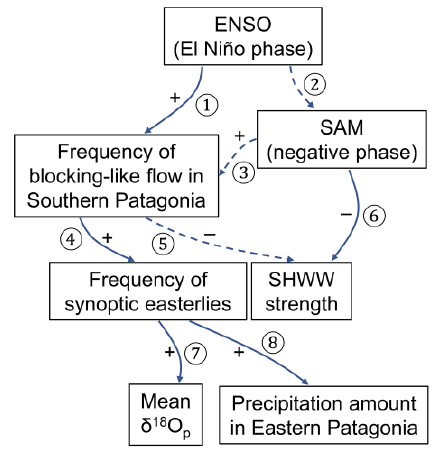
Figure 9. The process-based interpretive diagram to link the large-scale climate mode with regional climate and δ 18 O p in Southern Patagonia in a paleoclimate setting. The plus and minus symbols show the direction of changes (strengthening or weakening, respectively). The solid and dashed arrows show the direct and indirect connections, respectively. The tropical Pacific Ocean (ENSO) could generate Rossby wave train propagating the tropospheric mass divergence anomalies to mid- and high-latitude of the Southern Hemisphere. Under the El Niño phase, the frequency of blocking-like flow in Southern Patagonia would increase ( ① ) [39,71] . This Rossby wave train is responsible for the apparent ENSO–SAM phase teleconnection ( ② ) [77,80] , as the circulation anomalies of blocking-like flow is similar to the negative phase of the SAM (reduced mean SLP gradient across the Drake Passage) ( ③ ). The increased occurrence of quasi-stationary blocking-like flow would increase the occurrence of synoptic easterlies in Southern Patagonia ( ④ ). As a result, the overall strength of the prevailing westerlies would be reduced ( ⑤ ), although the strength of the hemisphere-wide SHWWs is directly related to the SLP gradient between mid- and high-latitude characterized by the phase of the SAM ( ⑥ ). As the synoptic easterlies became more frequent, their representation in regional precipitation in Eastern Patagonia would he higher, increasing the mean δ 18 O p over long timescales ( ⑦ ). In addition, the synoptic easterlies are more often associated with larger precipitation events that would increase the overall precipitation amount and weaken the Andean rain shadow in Eastern Patagonia ( ⑧ ) [47] . 5.5. Implications for Paleoaltimetry Reconstruction Our results also have implications for isotope-based paleoaltimetry reconstruction in Southern Patagonia and, by extension, Northern Patagonia and other regions with similar settings such as the South Island in New Zealand (leeward side with a single dominant moisture transport pathway) [11,81]. Traditionally, these studies have assumed that a single dominant moisture transport pathway such as the strong SHWWs in Patagonia has also persisted throughout geological timescales. Under this assumption, any negative temporal shift in δ 18 O p in the modern leeward side could be interpreted as the development of isotopic rain shadow and used to estimate the surface elevation in upwind locations using an empirical isotopic lapse rate [12,37]. This study, however, shows that an additional complexity is involved in properly interpreting the signal of surface uplift from leeward isotope data. Specifically, the shifts in δ 18 O p can be alternatively caused by changes in moisture transport pathways under different atmospheric circulation patterns even in a region where today there seems to only have a single dominant moisture transport pathway. As such, shifts in Antarctic sea ice extent, Southern Hemisphere meridional sea surface temperature gradient, and tropical ocean-atmosphere system can also impose